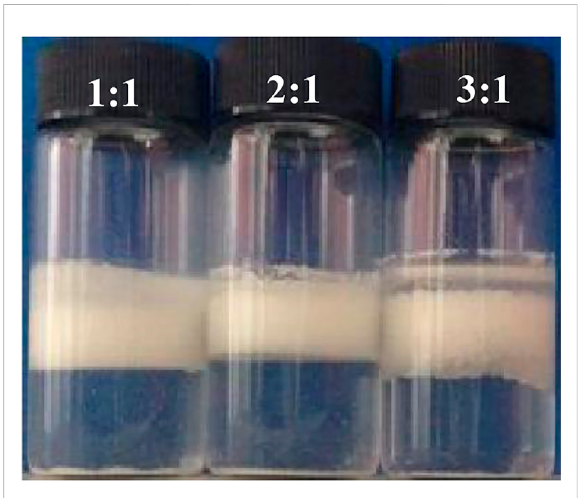
Appearance of the water-in-toluene-in-water multiple emulsions, taken 1 week after preparation. The inner W/O emulsion is stabilized by 1.0 wt% CaCO 3 nanoparticles in combination with 3 × 10 − 3 mol/L SDS, and the outer aqueous phase is stabilized by 1.0 wt% CaCO 3 nanoparticles together with 3 × 10 − 4 mol/L SDS. The volume ratio of inner water-in-toluene/ outer aqueous phase is shown in the